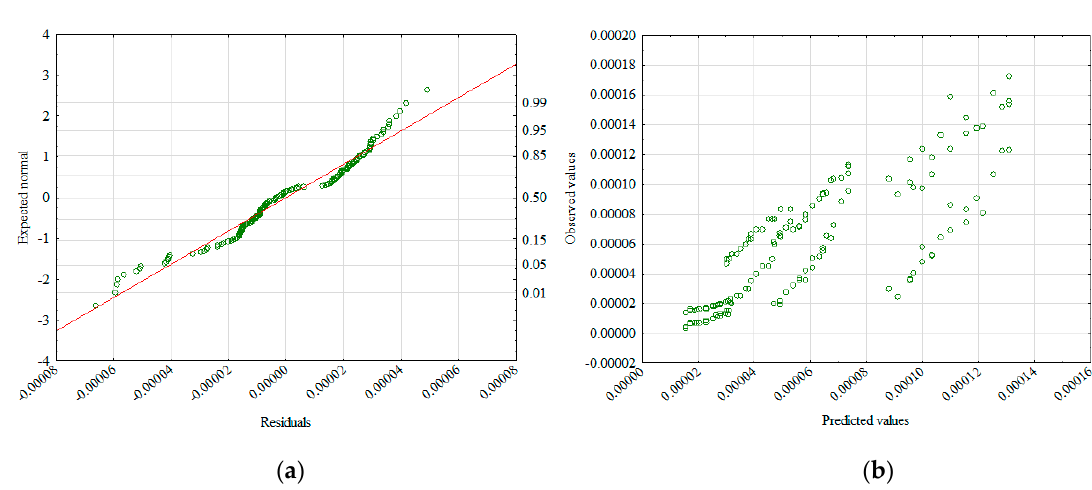
Figure 7. Normality diagram of residuals ( a ) and values observed against predictions ( b ).